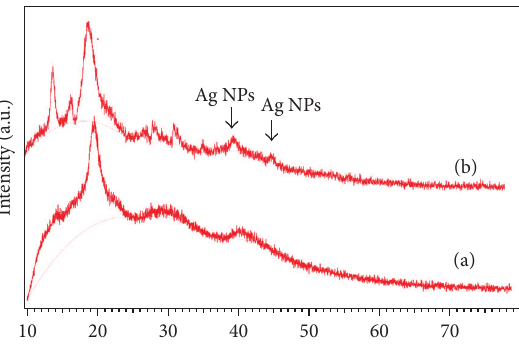
Figure 3: XRD profiles of CP (a) and CPA 1 (b) gels.